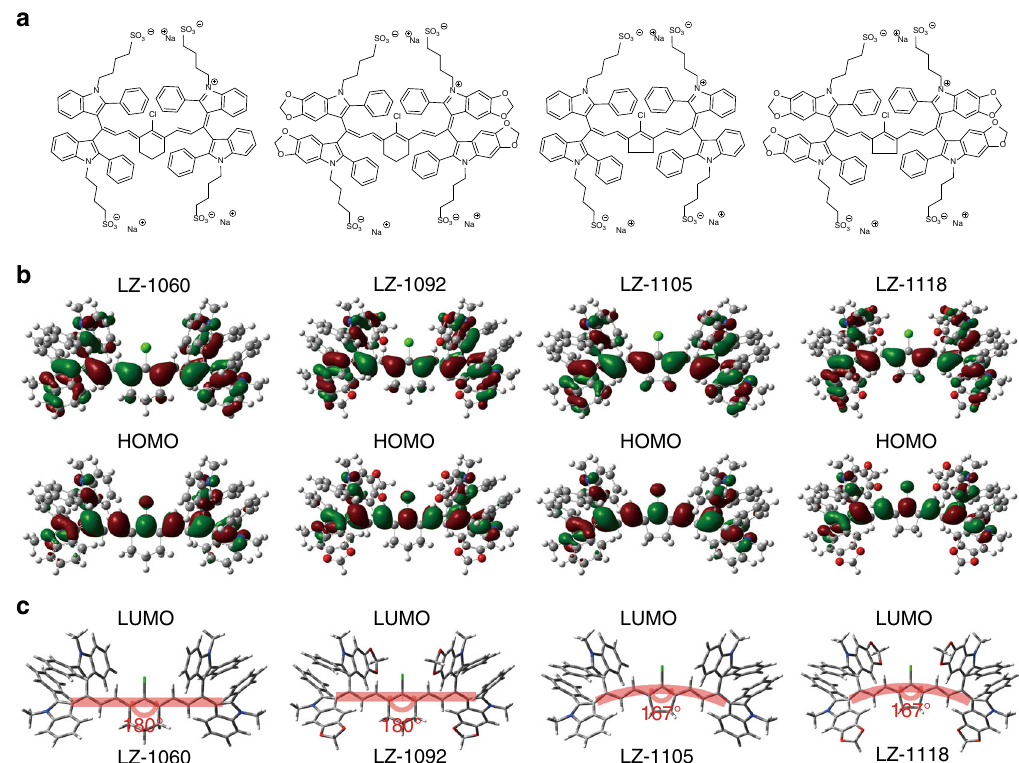
Fig. 6 Density functional theory calculations for LZ dyes. a The chemical structures of LZ dyes. b The HOMOs and LUMOs were plotted based on the optimized S1 geometries of the LZ dyes. c Optimized geometries of the LZ dyes in ground